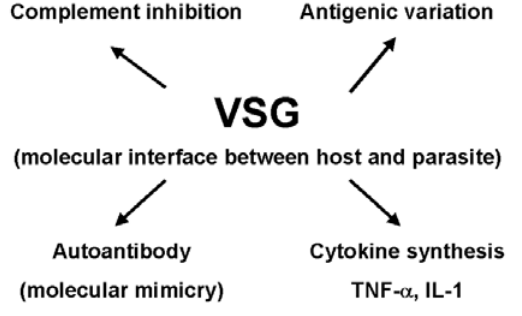
Fig. 1 – Variable surface glycoprotein (VSG), the major surface component of trypanosomes, is also released in host fluids. VSG induceresistancetocomplementlysis, escapetospecificimmune response, persistent cytokine production, autoantibody synthesis by molecular mimicry with host